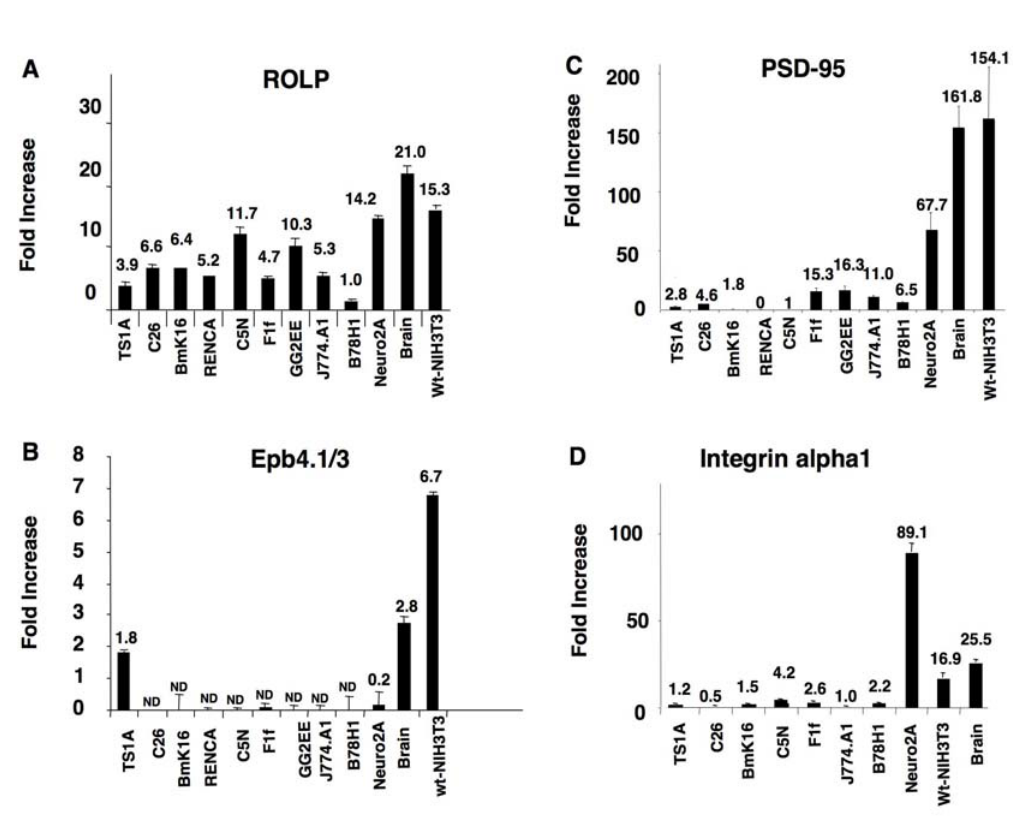
Figure 3. Tissue expression profile of ROLP, Epb4.1/3, PSD95 and Integrin-alpha1. (A, B, C, D) The analysis of the mRNA expression was performed by Real Time PCR. Results were normalized to an housekeeping gene expression (GAPDH). Each bar represents the mean 